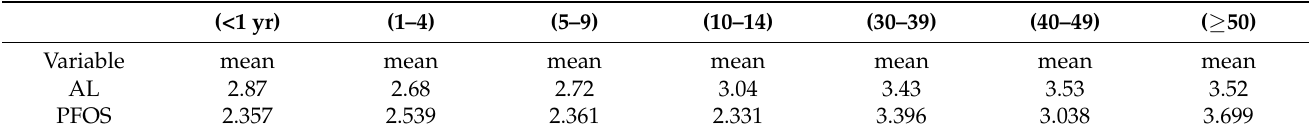
Table 6. Mean PFOS concentration and AL by length of time in the U.S.